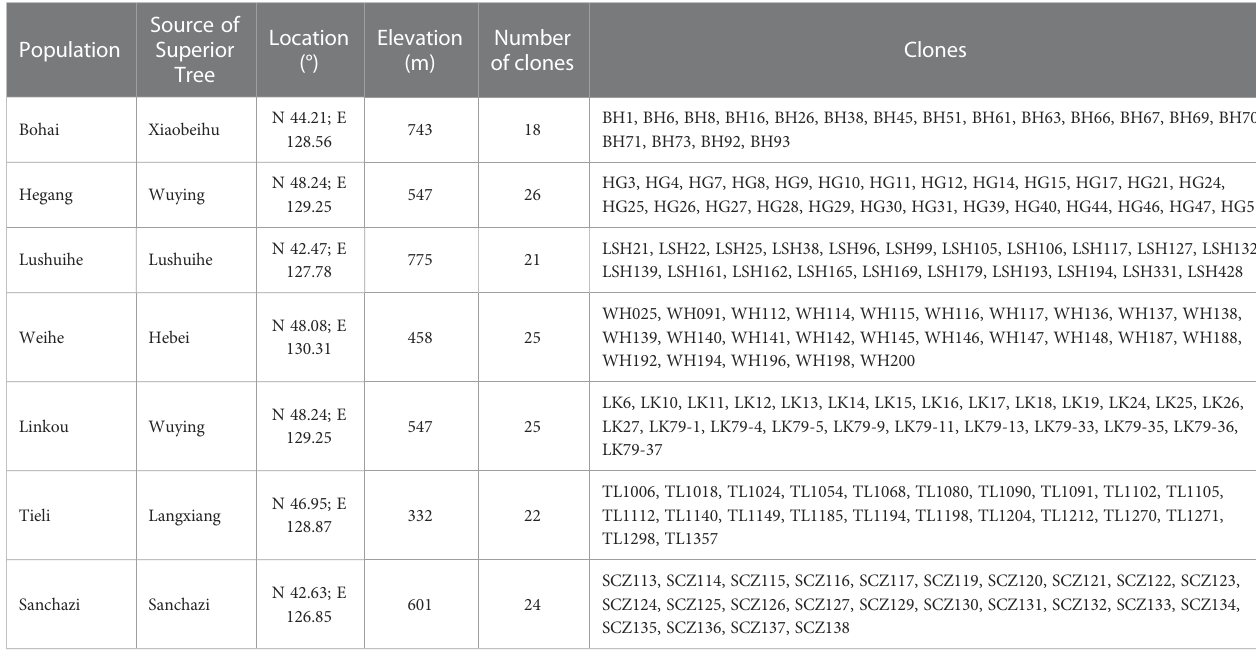
TABLE 1 Summary of material source